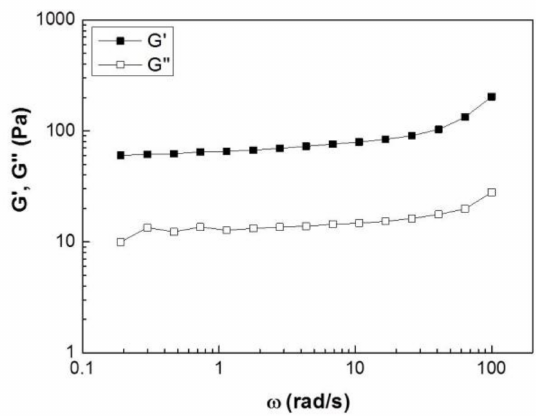
Figure 5. Linear viscoelastic response measured by a Dynamic frequency sweep test for a 3 mg/mL collagen hydrogel at 37 ◦ C. The elastic modulus, G’, is represented by solid symbols and the viscous modulus, G”, by open ones.